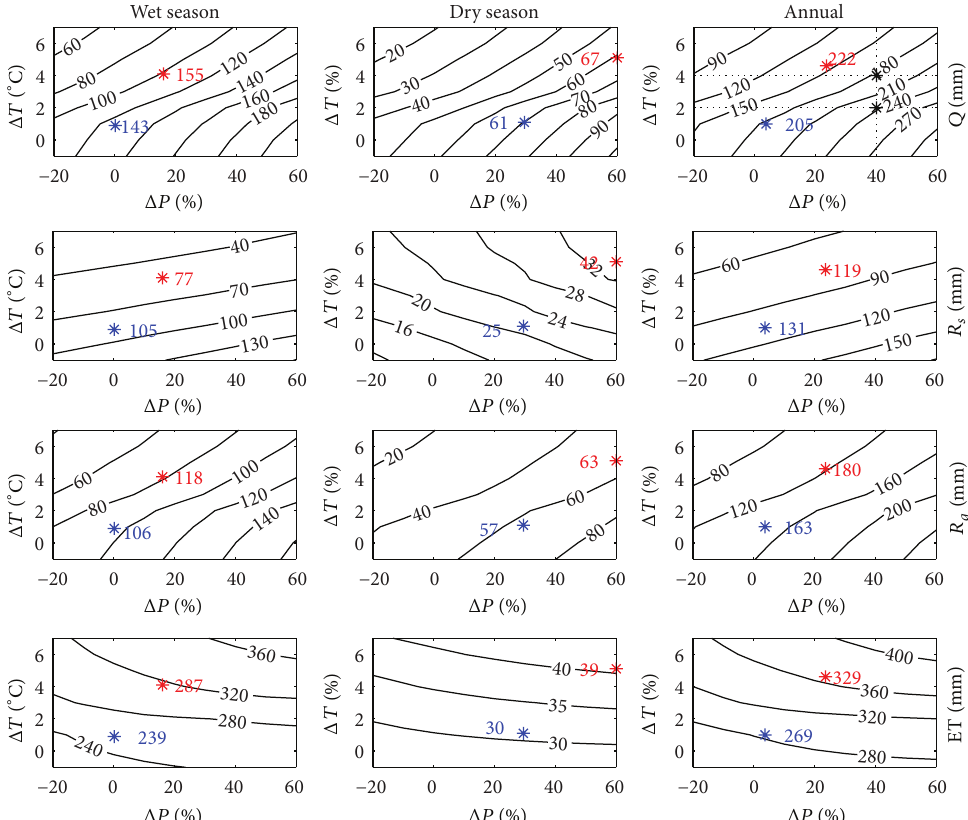
Figure 4: Response surfaces of streamflow ( 𝑄 ), surface runoff ( 𝑅 𝑠 ), subsurface runoff ( 𝑅 𝑔 ), and evapotranspiration (ET) to climate change. The simulations with RCM outputs for 2020 ∼ 2039 under RCP4.5 and for 2080 ∼ 2099 under RCP8.5 (their corresponding meteorological changes are listed in Table 3) are indicated using blue and red stars with